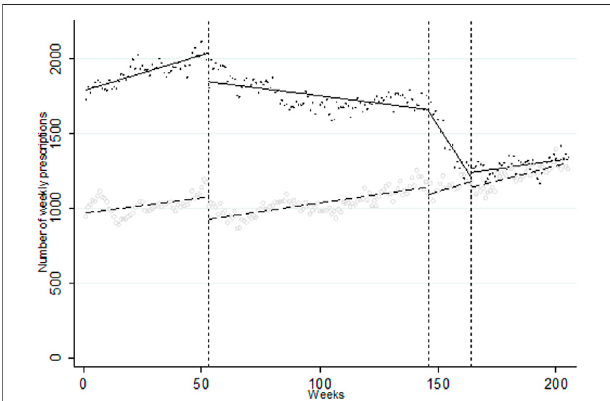
FIGURE 2 | Segmented linear regression trends of weekly series of IRF prescription for NCP using the weekly series of IRF prescription for BCP in patients with chronic cancer pain treatment as a control group, 2015 – 2018. Crosses/circles: observed weekly volume of prescription for NCP and BCP, respectively; Line/dotted line: predicted weekly volume of prescription forNCPandBCP,respectively.Week0: fi rstweekofJanuary2015;Week53: